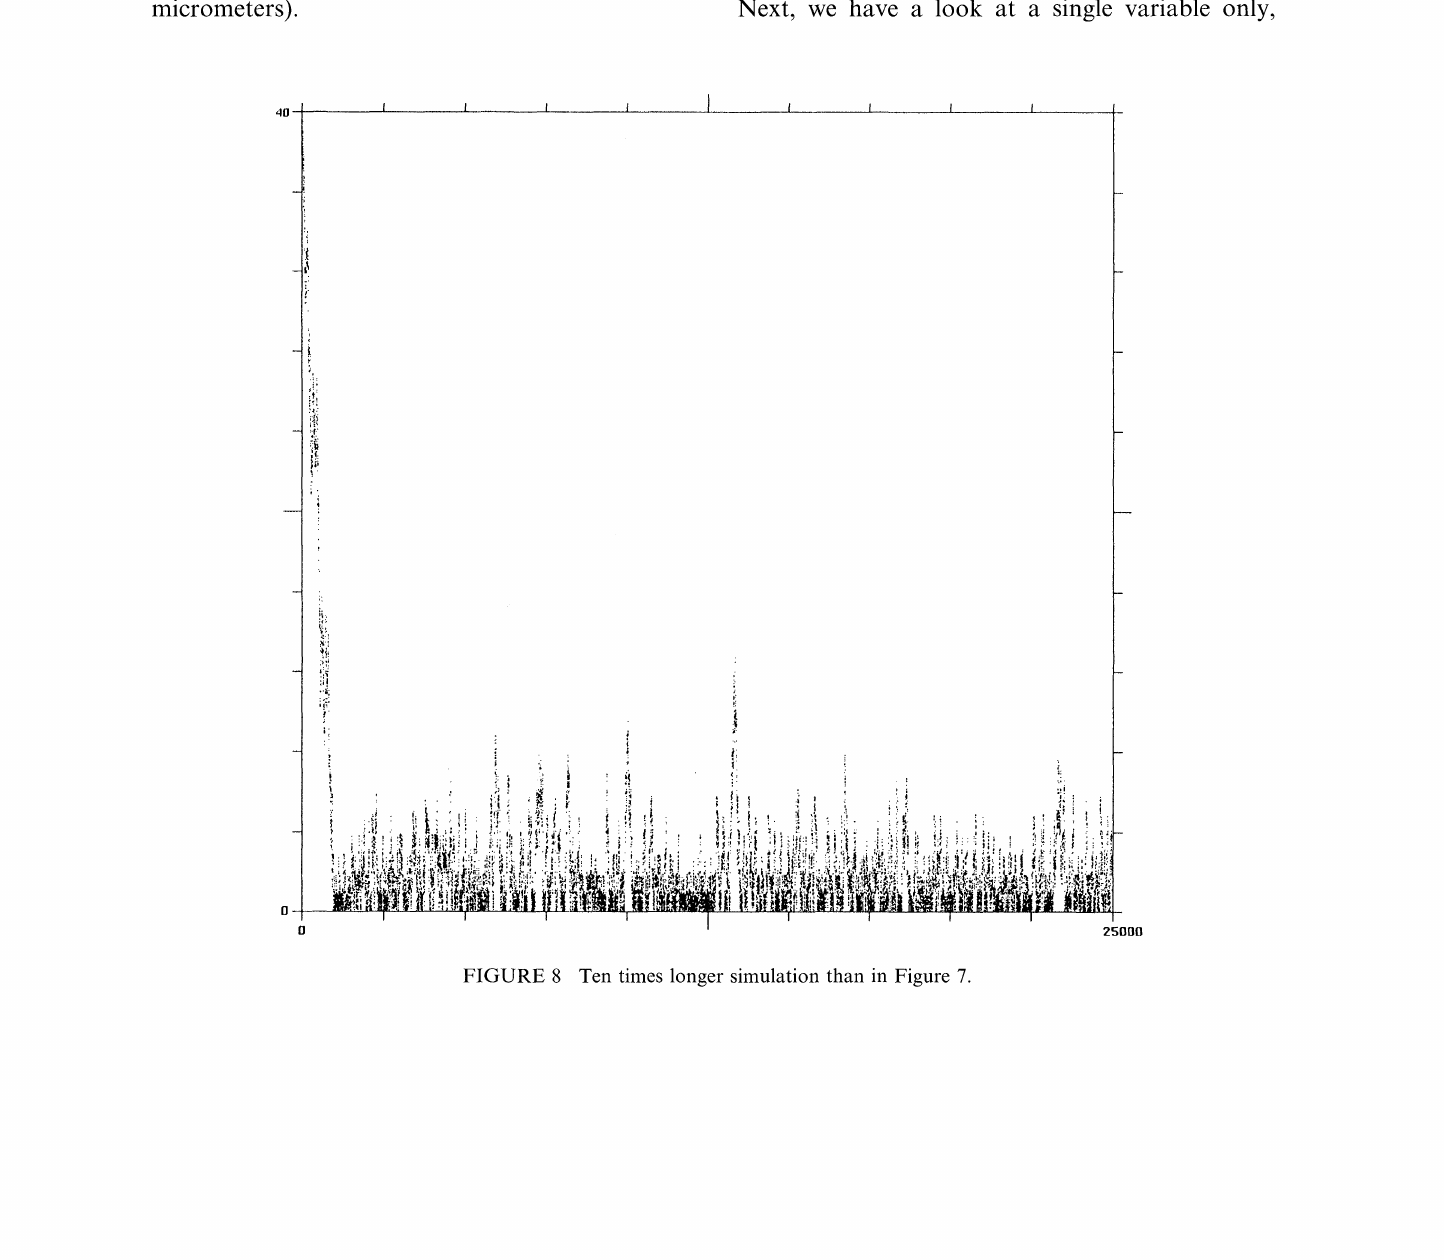
FIGURE 8 Ten times longer simulation than in Figure